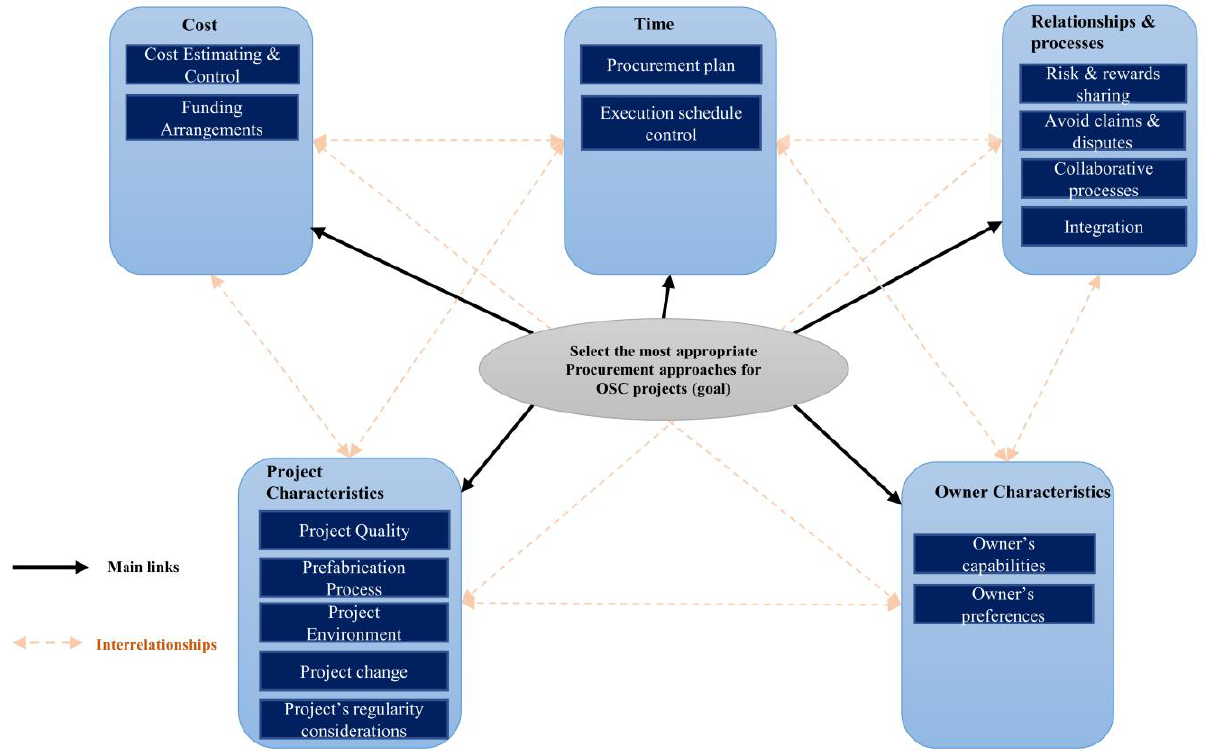
Figure 4. The interrelations identified among sub-criteria and main criteria .